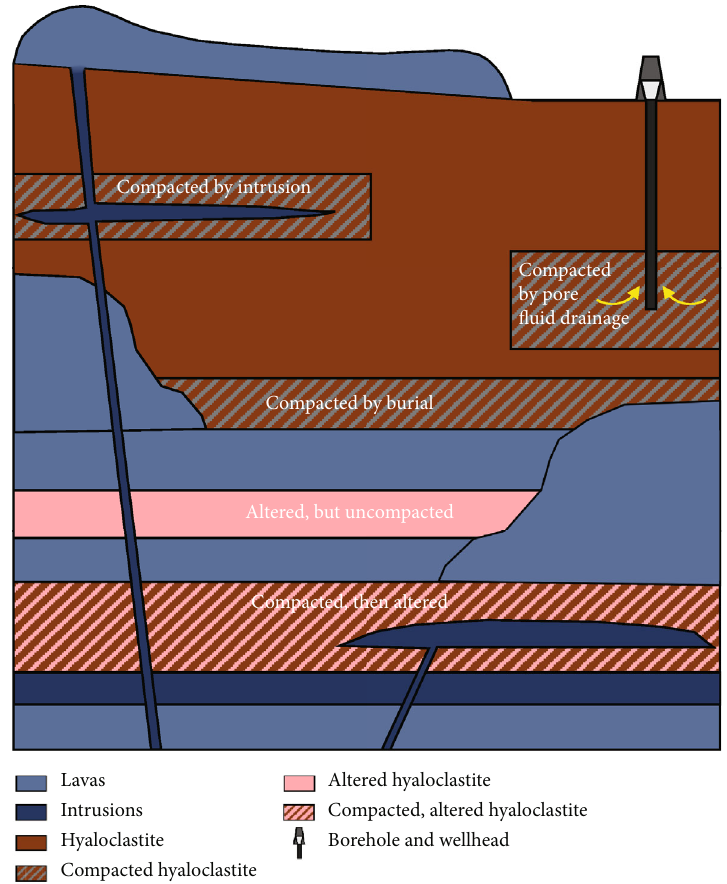
Figure 9: Conceptual model of hyaloclastite evolution in active volcanic hydrothermal systems exploited for geothermal energy. Hyaloclastite may be prompted to compact via external forcing (e.g., if buried under thick sequences of deposits/lava or if intruded by magma) or via reduction in pore fl uid pressure (whether via natural fl uxes or if fl uids are drained during geothermal energy harnessing). In some cases, hyaloclastites may undergo chemical alteration prior to compaction, if pressure and temperature conditions were favourable to trigger reactions. We note that in scenarios where the hyaloclastite is intruded by magma, we anticipate that breakdown of clays and zeolites (due to the high temperature experienced) may cause weakening of hyaloclastites, enhancing the likelihood of compaction (e.g., [75], this